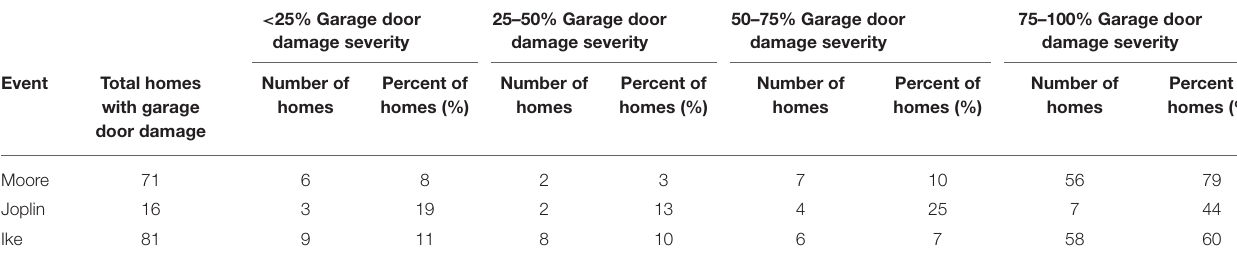
TABLE 4 | Garage door damage (damaged garages only) severity in 90–109 mph wind speeds.